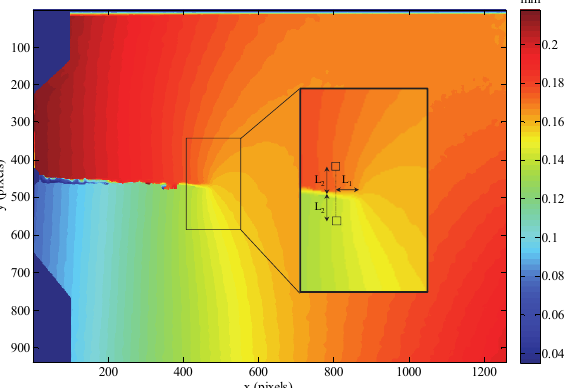
Figure 4: Magnification of the region around the crack tip showing a pair or points behind the crack tip employed for the CTOD measurement.